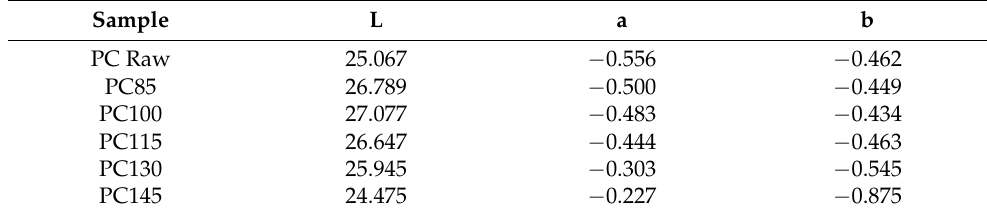
Table 1. The CIELAB values of the GF-PC composites before and after aged. Sample L a b PC Raw 25.067 − 0.556 PC85